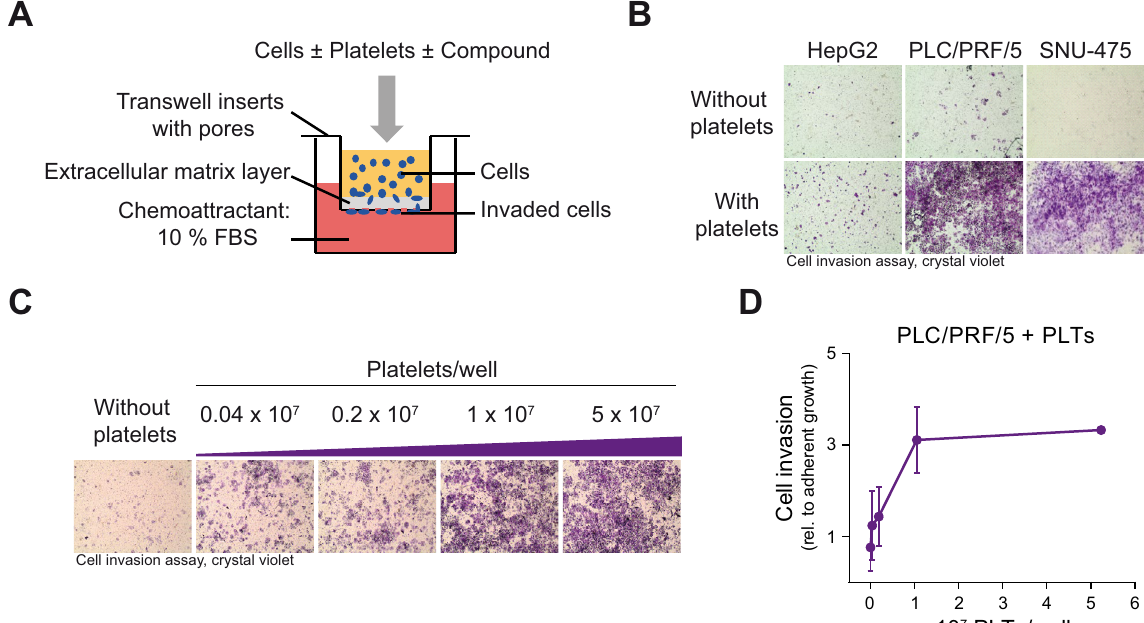
Figure 3. Platelets induce cellular invasion of HCC cells. ( A ) Schematic representation of the in vitro cell invasion assay in the presence of platelets. Platelets were isolated from human blood, combined with cells, and then placed into transwell inserts. FBS was used as a chemoattractant. Invaded cells at the bottom side of the transwells were stained with crystal violet for microscopy and photometrical quantification. ( B ) Cell invasion assay of HepG2, PLC/PRF/5 and SNU-475 cells with and without platelets (1.25 × 10 7 PLTs/well). Microscopic images show invaded and crystal violet stained cells. ( C ) Cell invasion assay of PLC/PRF/5 cells with an increasing number of platelets, 0.04 × 10 7 PLTs/well (1.6 × 10 3 PLTs/mm 3 ) up to 5 × 10 7 PLTs/well (200 × 10 3 PLTs/ mm 3 ). Microscopic images of invaded and crystal violet stained cells are shown. ( D ) Quantification of PLC/ PRF/5 cell invasion assay with an increasing number of platelets. The OD values from invasion assays were normalized to ODs from adherent growth. Data are presented as mean ± SD (n =